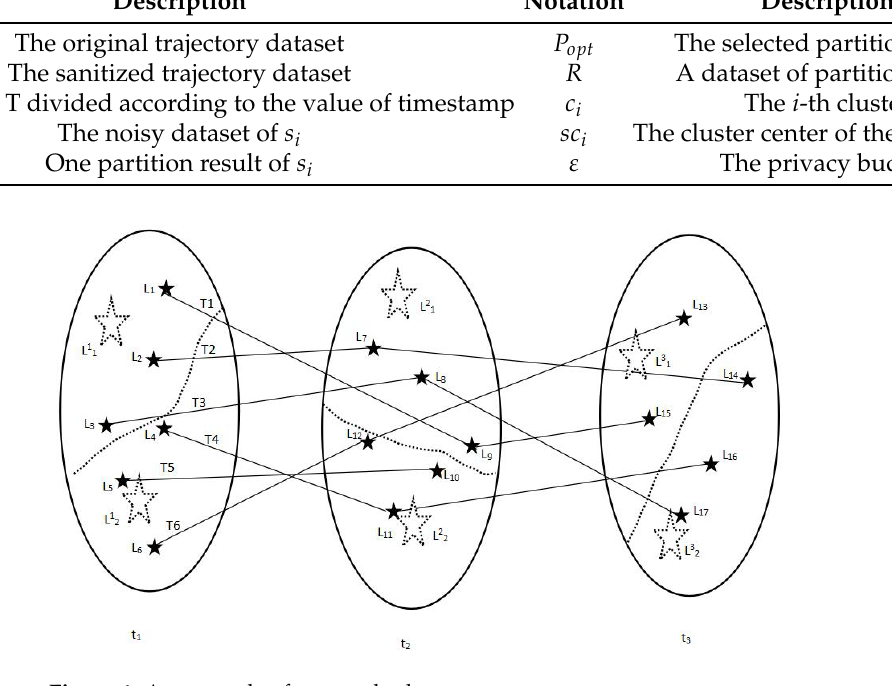
Figure 1. An example of our